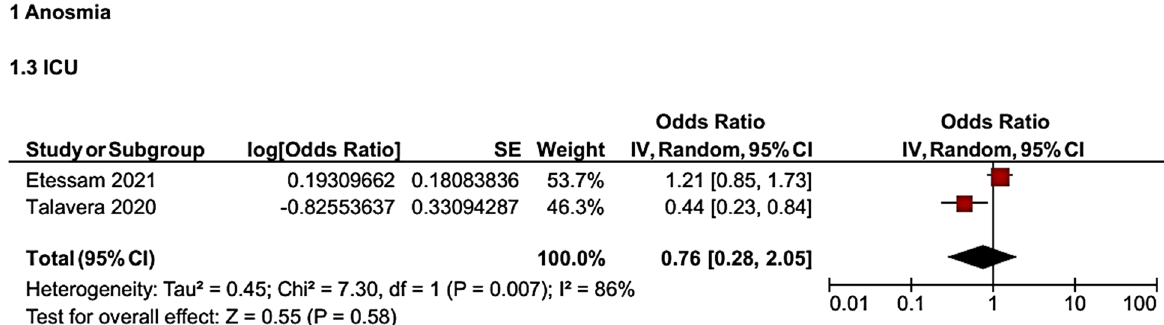
Fig. 3 Forest plot for the association of OD with hospitalization in ICU in COVID-19